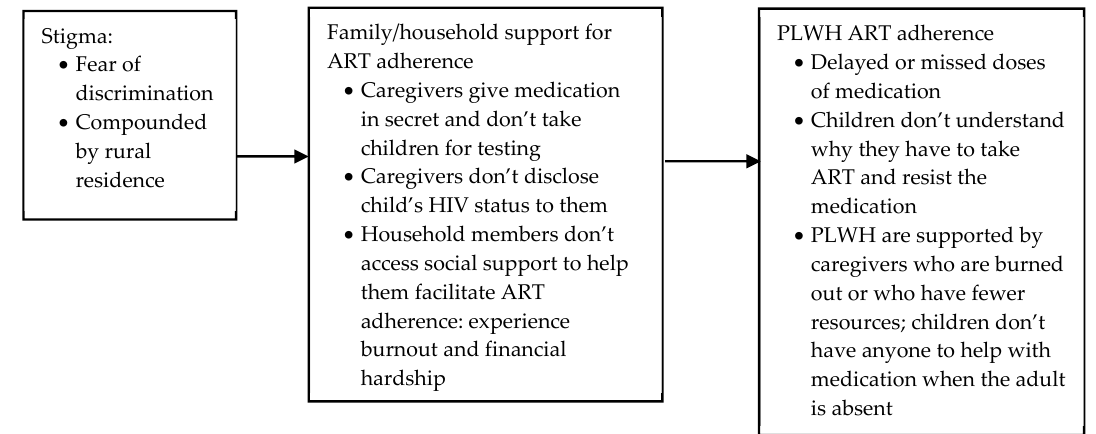
Figure 8. Impact of stigma on household support and, consequently, ART adherence.